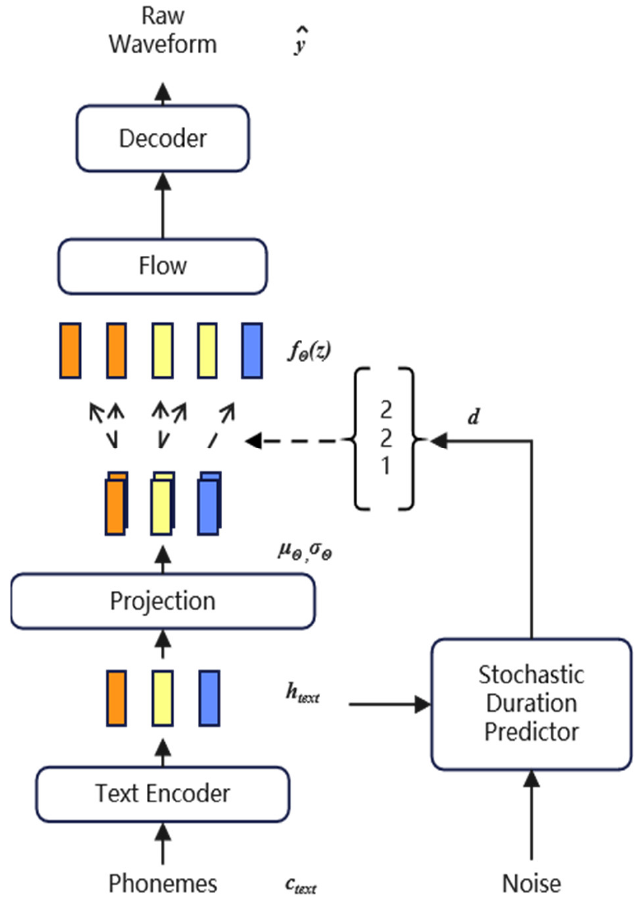
Figure 2. Inference procedure of VITS.